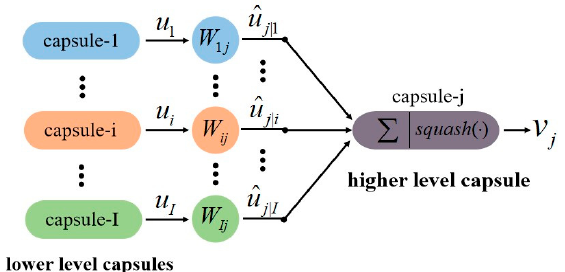
Figure 6. Connections between the lower level and higher level capsules.